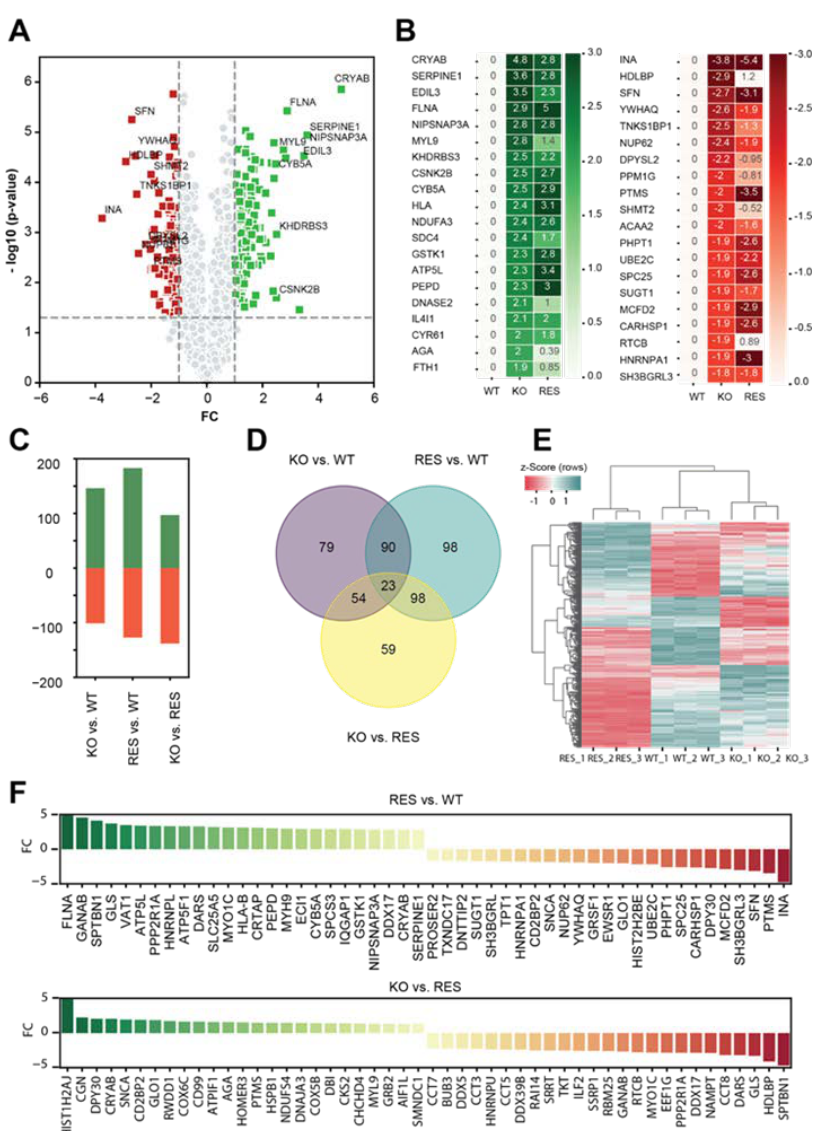
Figure 4. Overview of differentially regulated proteins in pairwise comparison. ( A ) Volcano plot illustrates the differentially regulated proteins (related to gene names) in the reference compari- son group between knockout (KO) and wild-type (WT). X -axis represents the log2-fold changes (FC) of LFQ intensities and y -axis –log10 ( p values). Up- and downregulated proteins in KO are labelled in green and red squares. ( B ) Heat map showing the average log2 LFQ intensities of top 20 up- and downregulated proteins from reference (KO vs. WT) in comparison to rescue (RES). ( C ) Bar charts representing the number of significantly regulated proteins in pairwise comparison. ( D ) Venn diagram illustrates the distributions of the significantly altered proteins from the pairwise comparisons. ( E ) Hierarchical clustering of the significantly regulated proteins from the pairwise comparisons. Single LFQ intensities of proteins are clustered in rows and columns using centroid linkage method and Euclidian distance measurement technique. Z-Score was used to normalize the data. Upregulated and downregulated proteins are represented with red and green colors. ( F ) The expression levels of top 25 significantly (trimmed log2 FC of 5, p value < 0.05) up- and downregulated proteins in different pairwise comparison groups: RES vs. WT, KO vs.